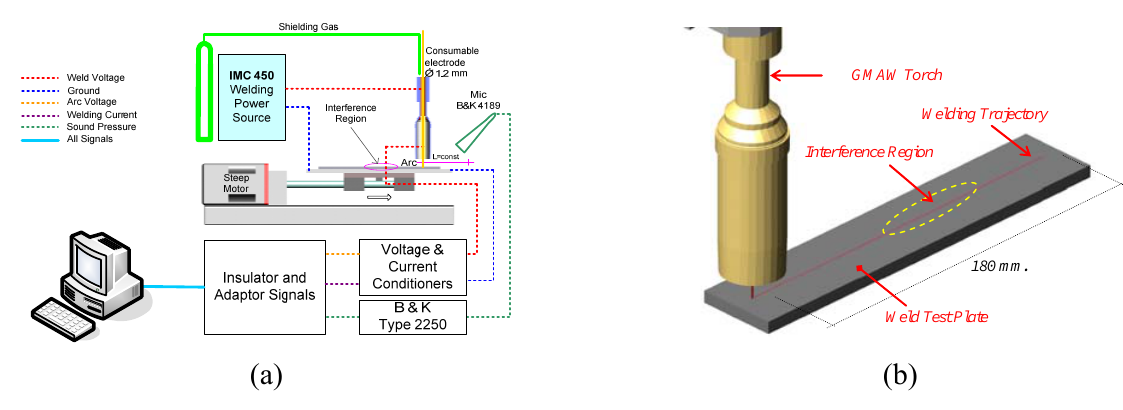
Figure 1. (a) Experimental Setup. (b) Welding Position.